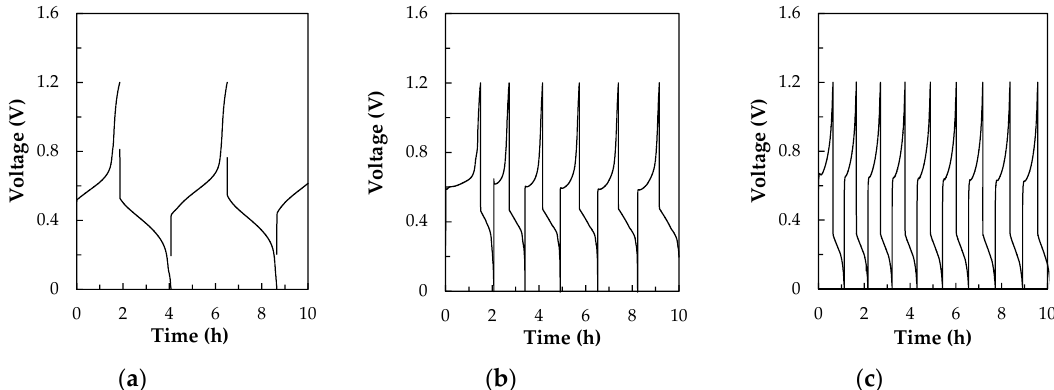
Figure 7. Charge-discharge diagrams of for V/I RFB. The 1.0 M VOSO 4 /2.0 M H 2 SO 4 was as the positive electrolyte, iodine/ascorbic acid solutions as the negative electrolyte by carbon paper electrode as the anode and cathode, respectively, N-117 membrane as a separator with a serpentine-type flow field at a flow rate of 60 mL/min with different current density by monitoring of the ITI ( a ) 20 mA/cm 2 , ( b ) 40 mA/cm 2 , ( c ) 60 mA/cm 2.